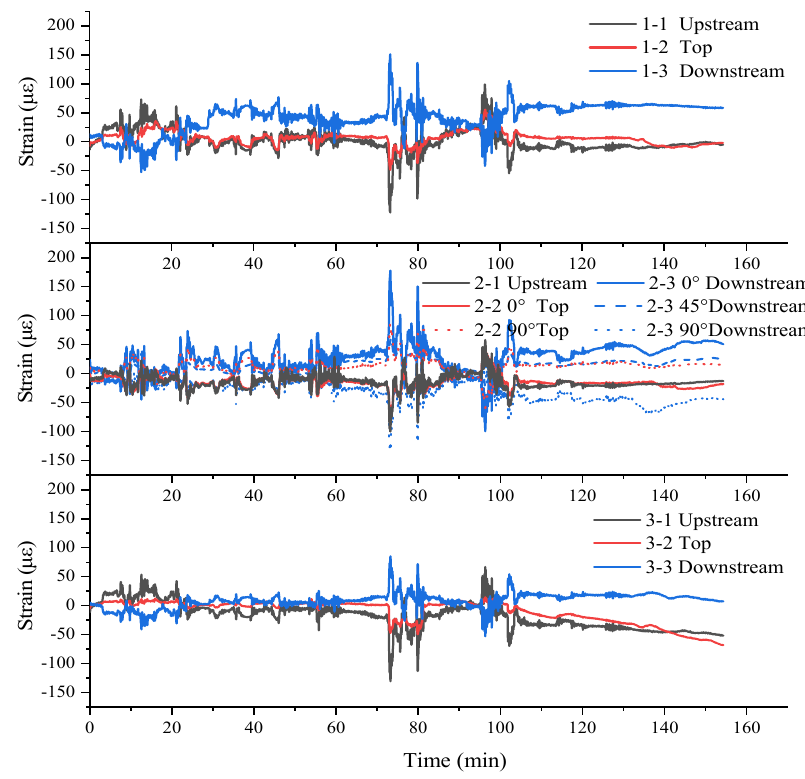
Figure 8. Pipeline Section 1 floating strain.